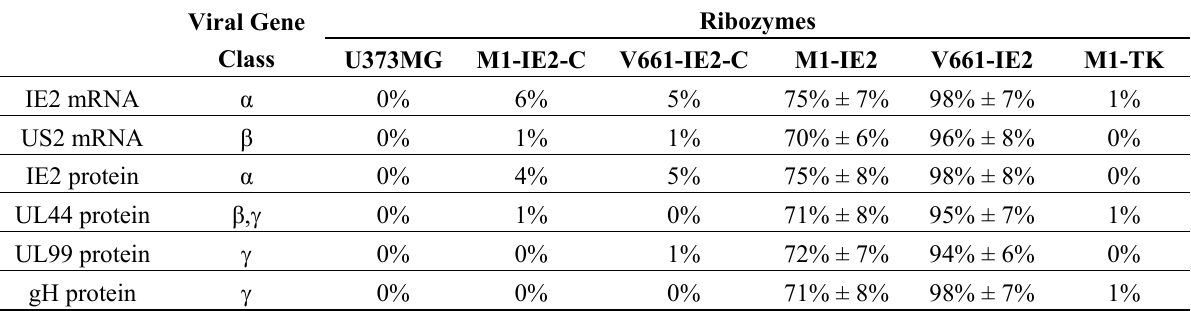
Table 2. HCMV mRNA and protein expression in cells expressing M1-TK, M1-IE2-C, V661-IE2-C, M1-IE2, or V661-IE2, and cells not expressing any ribozyme (U373MG). The values represent the levels of inhibition of gene expression as compared to the levels of inhibition in U373MG